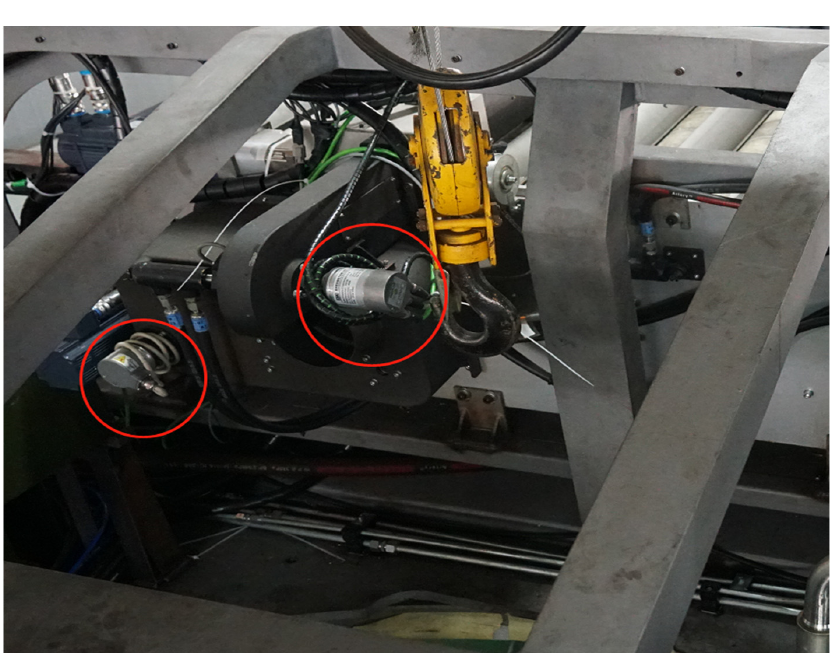
Figure 3. Schematic diagram of the sensor installation for the drug delivery mechanism.